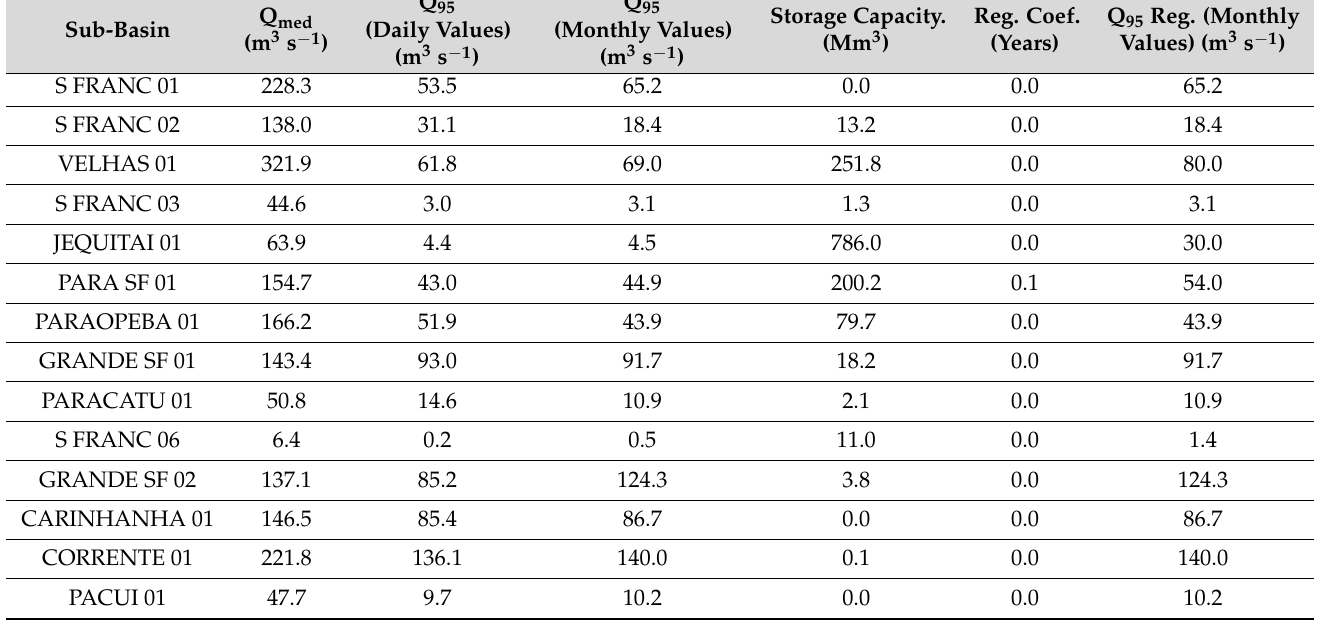
Table 5. Surface water availability and storage regulation capacity, per